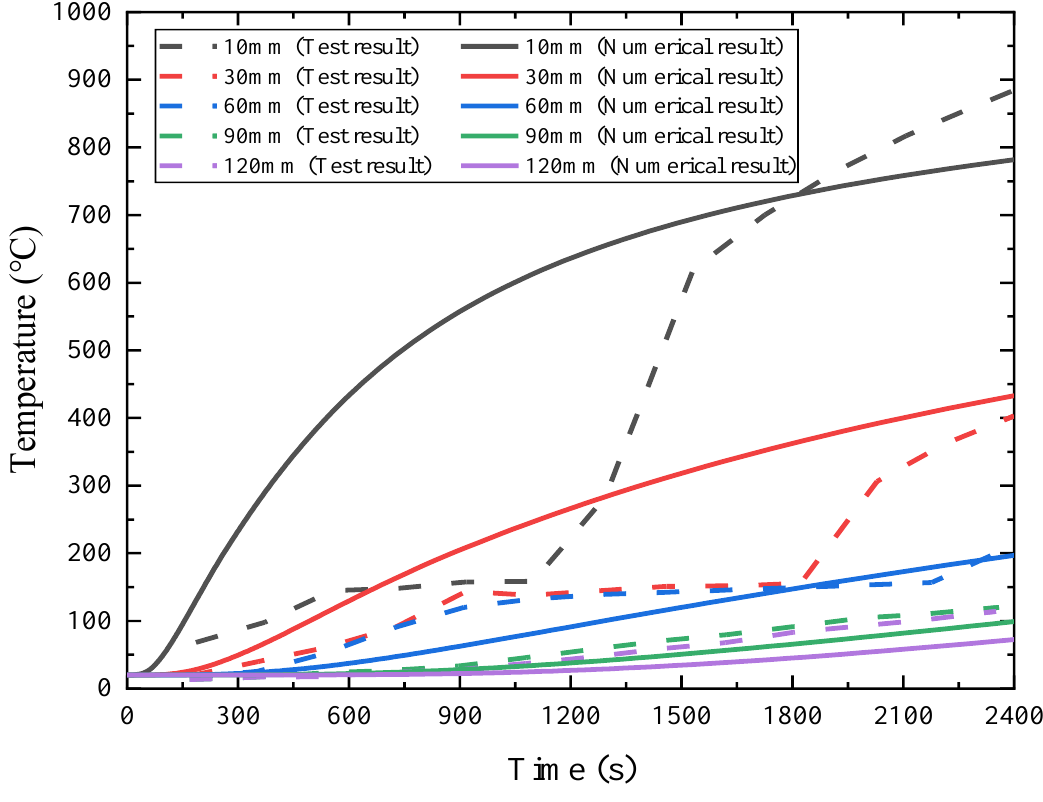
Figure 6. Comparison of the temperature field of specimen RCJ3.